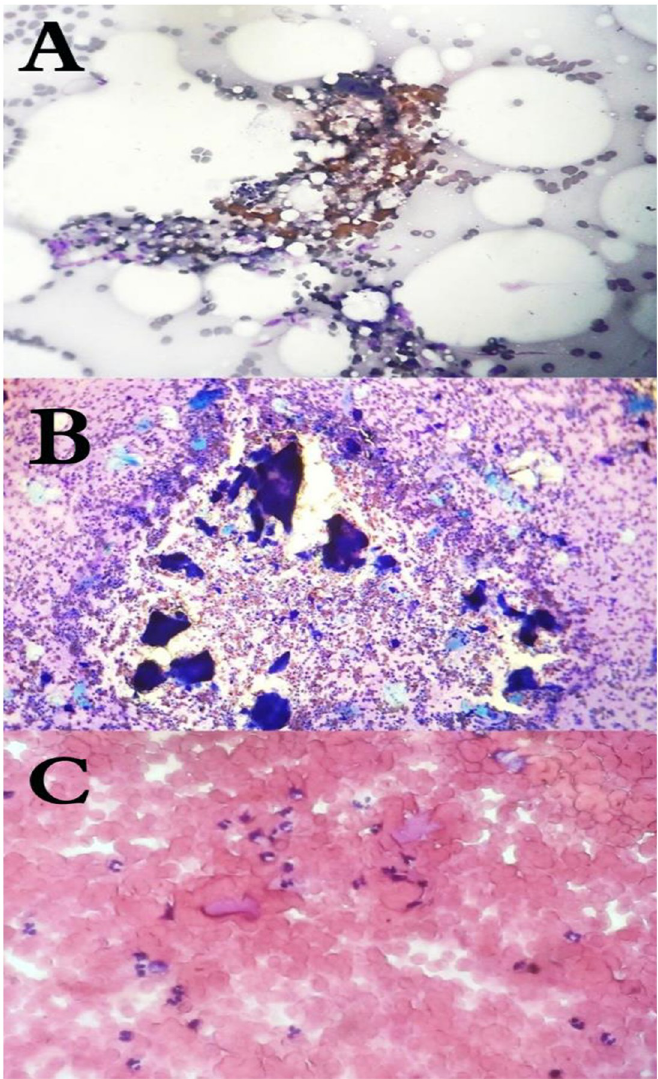
Fig 2. Cytology of mycetoma causative agents. ( A ): The cytological appearance of M . mycetomatis , ( B ): A . pelletierii , ( C ): S . somaliensis in fine needle aspirates stained with HE (magnification 10